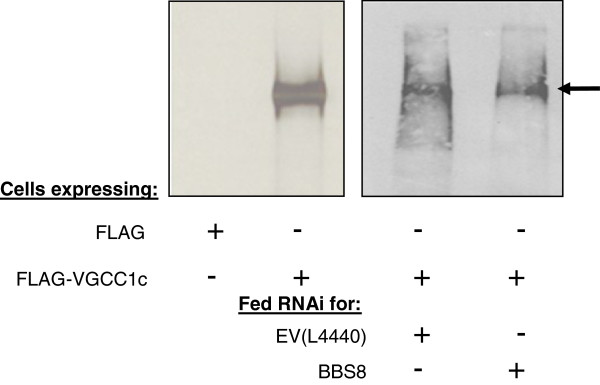
Immunoblots (ECL) of proteins immunoprecipitated from ciliary membranes. Ciliary membranes were solubilized in Triton X-114 and the proteins were immunoprecipitated using anti-FLAG affinity beads and separated on a 5-18% SDS-PAGE gel. (A) Control experiment where cells were expressing the empty FLAG vector (control) or FLAG-VGCC1c (TEST). The IP of the FLAG-VGCC1c can be seen in the TEST lane (arrow: 272 kD). (B) Cells expressing FLAG-VGCC1c were fed bacteria with the BBS8 RNAi plasmid (BBS8) or the empty RNAi vector (EV L4440) as a control. The immunoblots were developed using polyclonal anti-FLAG. Arrow indicates the band of the FLAG-VGCC1c proteins.